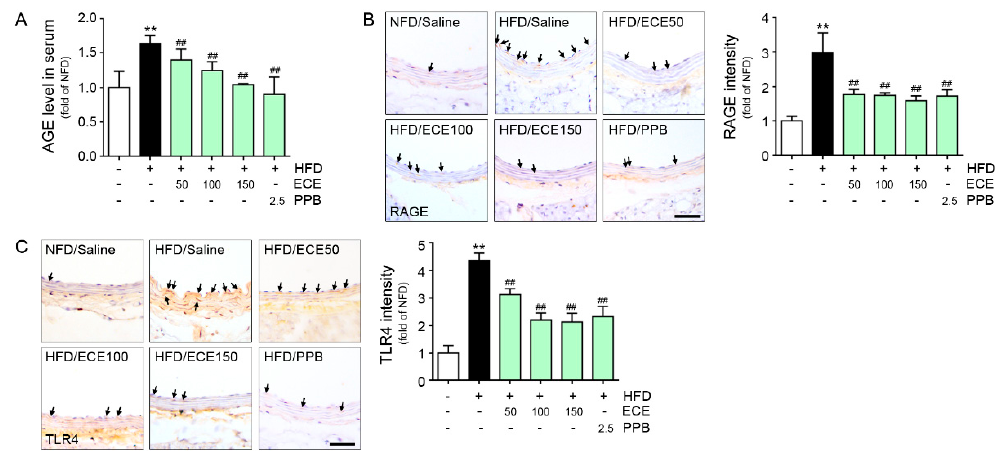
Figure 1. Comparative analysis of concentration-dependent ECE and PPB administration on the reduction of AGE and its receptor expression level in HFD-fed mice. ( A ) AGE levels were calculated in HFD-fed mice with or without ECE / PPB administration. ( B ) Light microscopic images showing RAGE expression (brown, arrow) in the aorta of HFD-fed mice. Quantitative graphs showing RAGE intensity from representative images. Scale bar = 50 µ m. ( C ) Light microscopic images showing TLR4 expression (brown, arrow) in the aorta of HFD-fed mice. Quantitative graphs showing TLR4 intensity from representative images. Scale bar = 50 µ m. **, p < 0.01 vs. NFD / Saline group; ##, p < 0.01 vs. HFD / Saline group. AGE, advanced glycation end products; ECE, Ecklonia cava extract; HFD, high-fat diet; NFD, normal fat diet; PPB, pyrogallol-phloroglucinol-6,6-bieckol; RAGE, receptor for advanced glycation end products; TLR4, toll-like receptor 4.